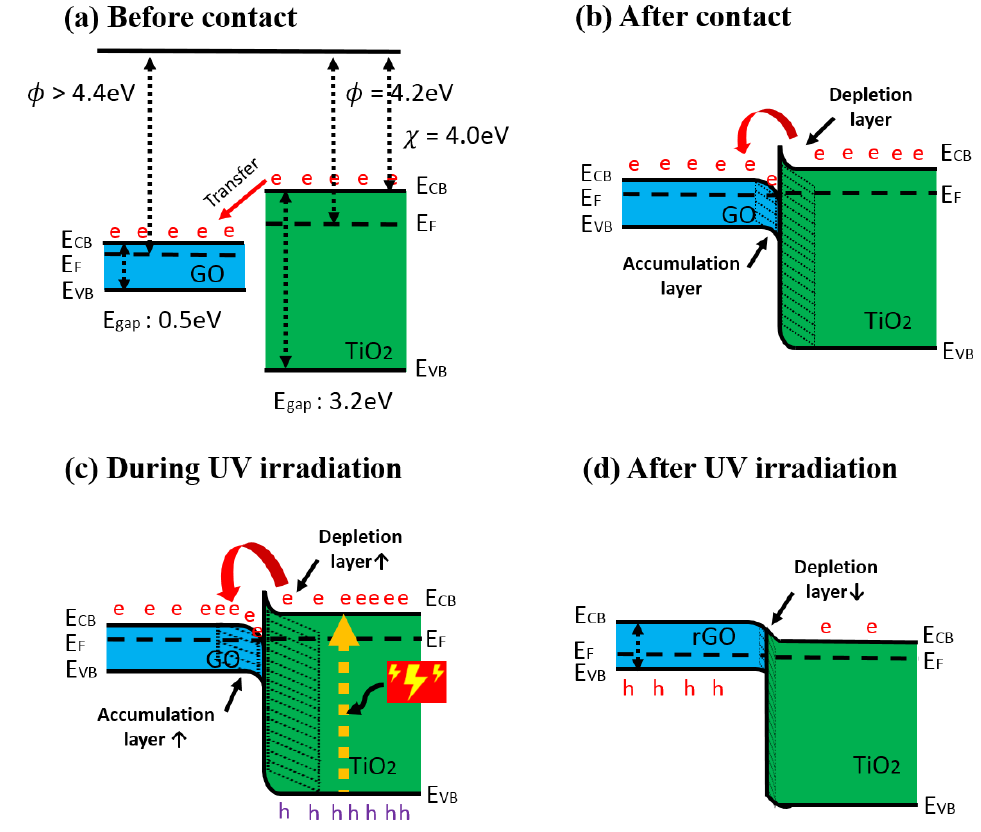
Figure 8. The proposed band diagram of GO/TiO 2 composite ( a ) before contact, ( b ) after contact, ( c ) during UV irradiation, and ( d ) after UV irradiation. (e: electron, h: hole).